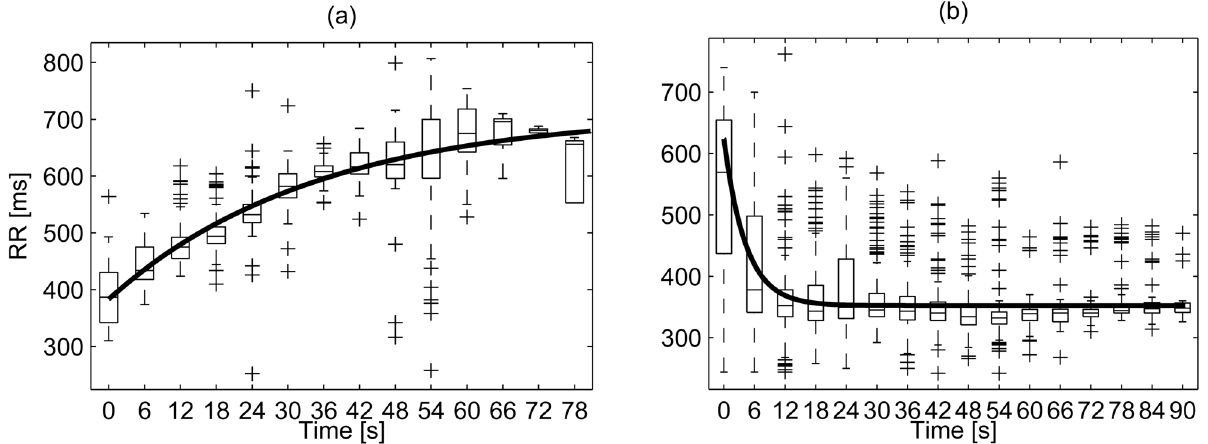
Figure 2. Example of estimation of the fRR time constants during cord occlusion and subsequent recovery. Panel (a): fRR during mechanical cord occlusion. The data belongs to the fetus of sheep # 3 (Table 1). Panel (b): fRR during recovery after UCO for the same case. Box plots summarize the values of fRR at a given time distance from the occlusion (or its release). The model prediction is reported with a bold line. The vertical lines delimit the ‘‘whiskers’’ and the + signs the outliers.